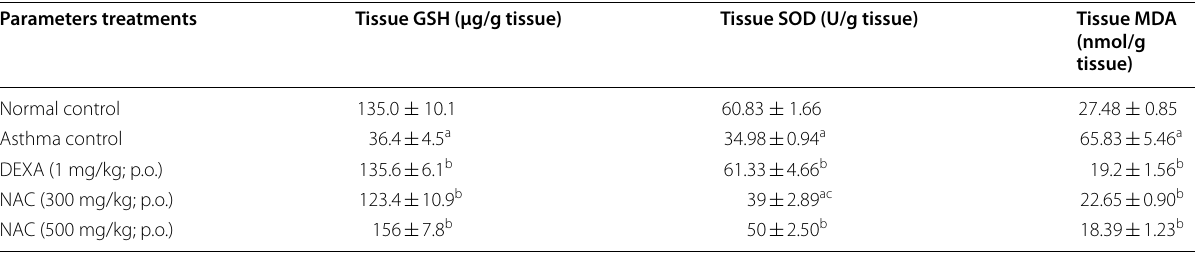
Data were expressed as mean SEM (N 8 rats). Statistical analysis was carried out by one‑way analysis of variance (ANOVA) followed by Bonferroni test ± = a Significantly different from normal control at p < 0.05 b Significantly different from asthma control group at p < 0.05 c Significantly different from DEXA group at p <